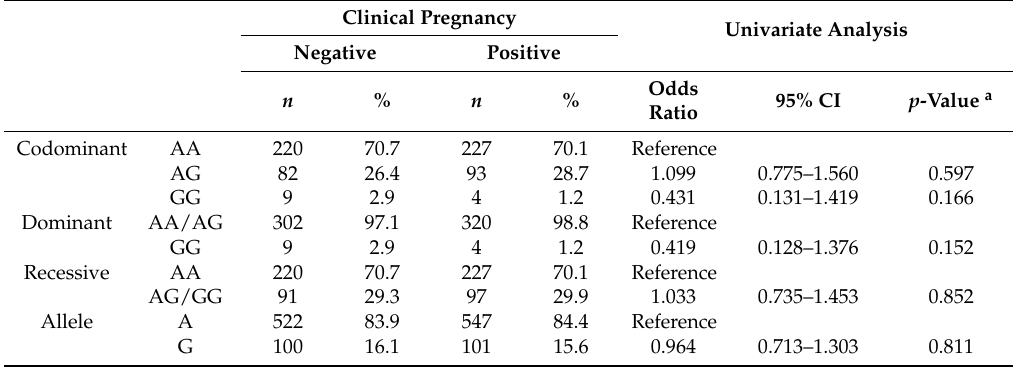
Table 5. Frequencies of AMHRII − 482 A > G (rs2002555) polymorphism among women with different IVF outcome.